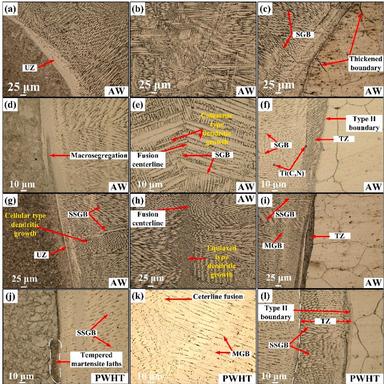
Optical micrographs of (a) P91 weld interface (near weld top); (b) WFZ (near weld top); (c) IN 800HT weld interface (near weld top); (d) P91 weld interface (near weld center); (e) WFZ (near weld center); (f) IN 800HT weld interface (near weld center); (g) P91 weld interface (near weld root); (h) WFZ (near weld root); (i) IN 800HT weld interface (near weld root); (j) P91 weld interface (near weld center); (k) WFZ (near weld center); (l) IN 800HT weld interface (near weld center).